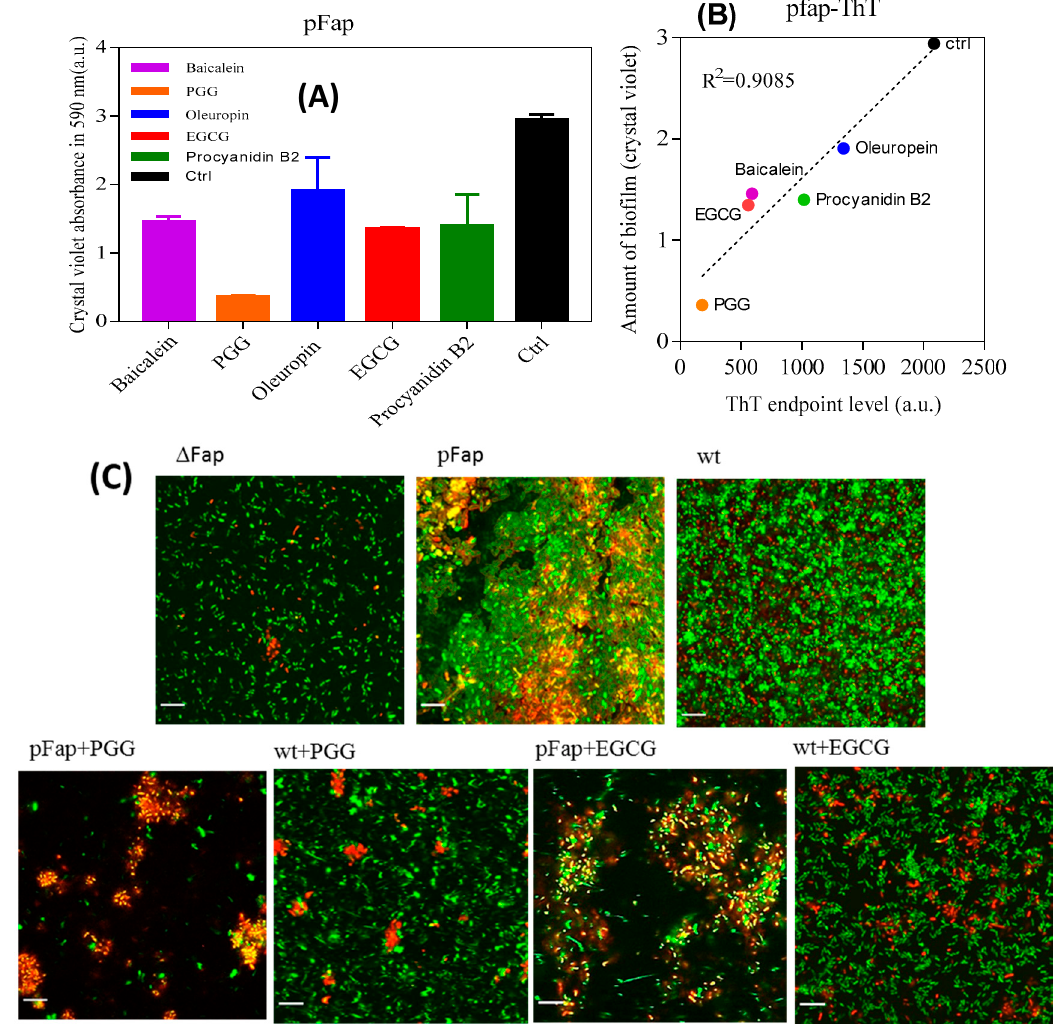
Figure 9. Effect of polyphenols on Pseudomonas biofilm. ( A ) The amount of biofilm formed in the presence of polyphenols (100 µM) by Pseudomonas overexpressing the fap UK4 operon; ( B ) correlation between the amount of biofilm and endpoints level of ThT fluorescence for FapC protein incubated with and without polyphenols; ( C ) confocal microscopy images of pFap and wt incubated with and without 100 µM PGG and EGCG. The bacteria were stained with live/dead stain: Red and green denote dead and live bacteria, respectively, all images were taken with 63× oil objective, scale bars are 10 µm.